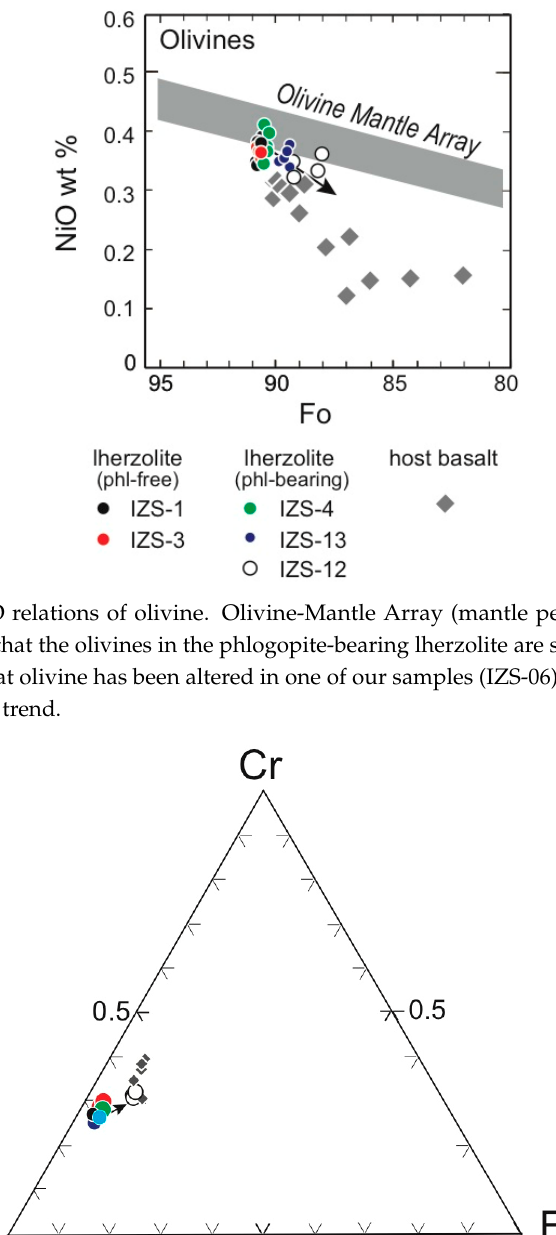
. Figure 8. Fo (olivine)-Cr# (chromian spinel) relations. The main part of ( a ) is enlarged as ( b ). The field between the broken lines is the olivine–spinel mantle array (OSMA) [41]. The field of abyssal peridotites is after Arai [41]. Note that olivine has been altered in one of our samples (IZS-06). The arrow indicates a possible metasomatic trend. Note that the phlogopite-free lherzolite is very confined on the Fo(olivine)-Cr# (spinel) space.